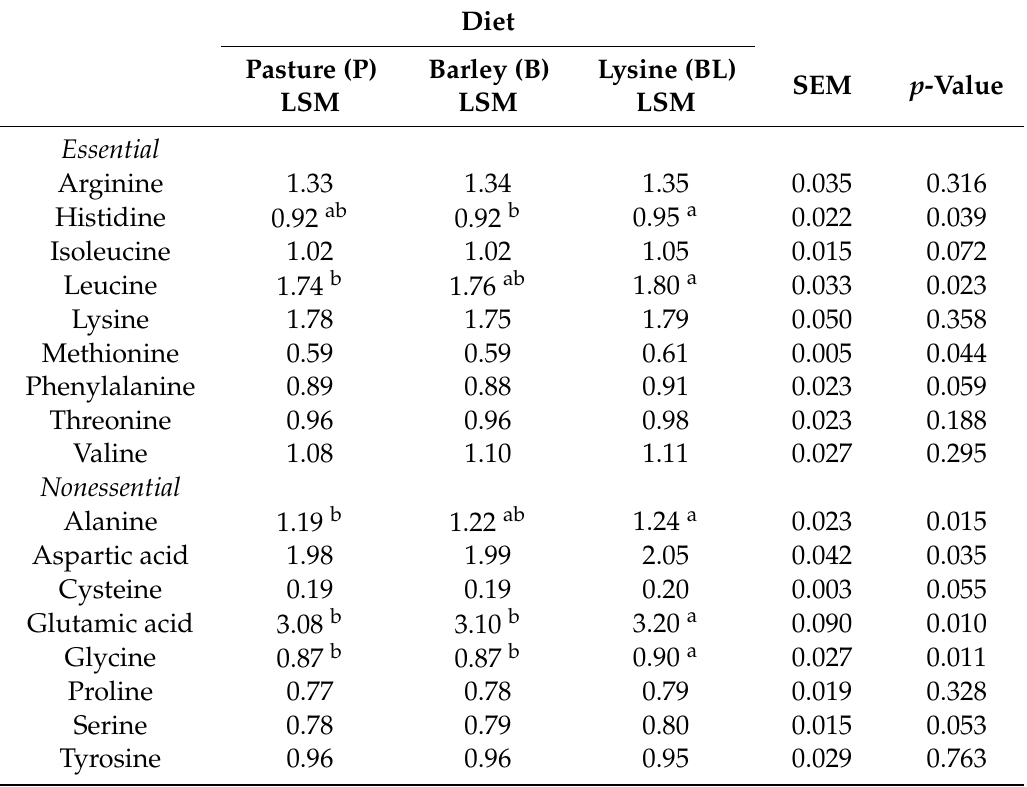
Table 4. Amino acid composition (g / 100 g muscle) of the longissimus lumborum muscle from fallow deer fed di ff erent